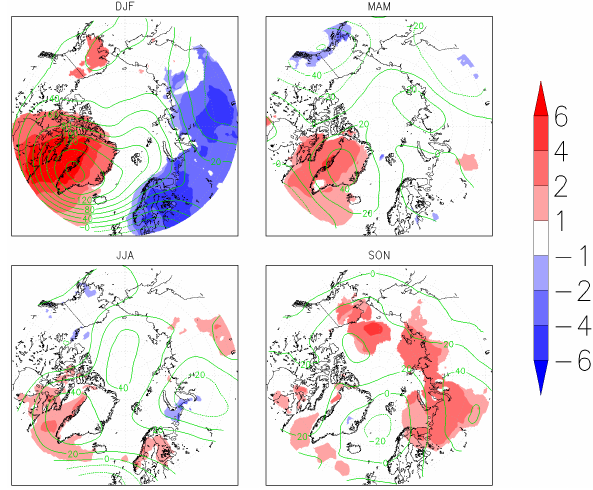
Figure 3. Seasonal difference maps (years with mild winters mi- nus years with cold winters) in air temperature at 1000hPa level (shading with confidence level of 95%), and geopotential height at 500hPa level